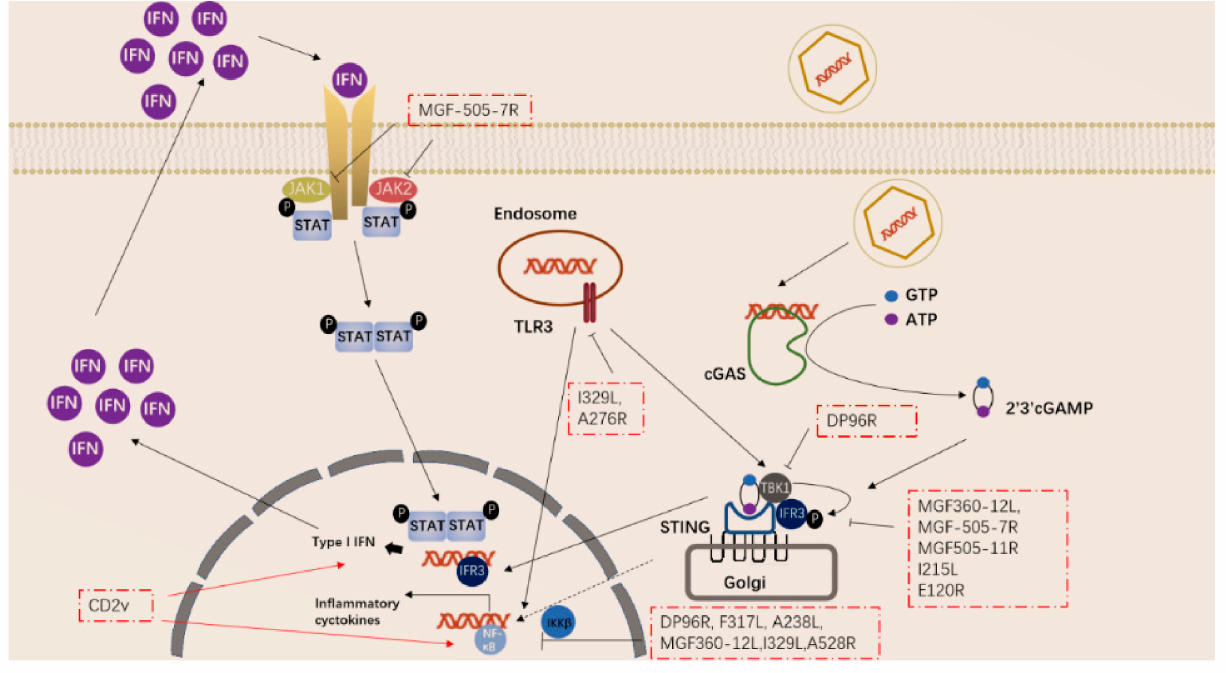
Figure 2. ASFV genes regulate innate immune signaling pathway. ASFV encodes multiple genes involved in suppressing the cGAS-STING signaling pathway. In 2013, Correia et al. reported that A528R (MGF530) could inhibit the